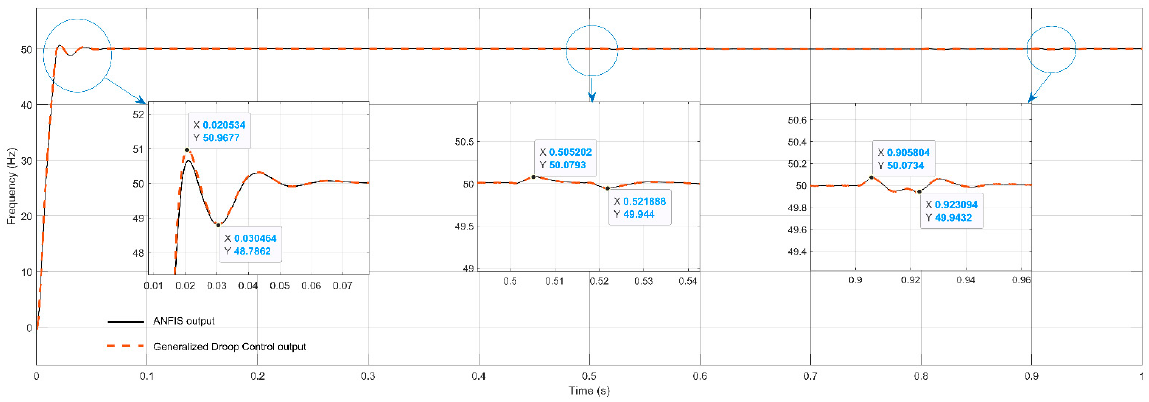
Figure 17. Comparison of DC link voltage.